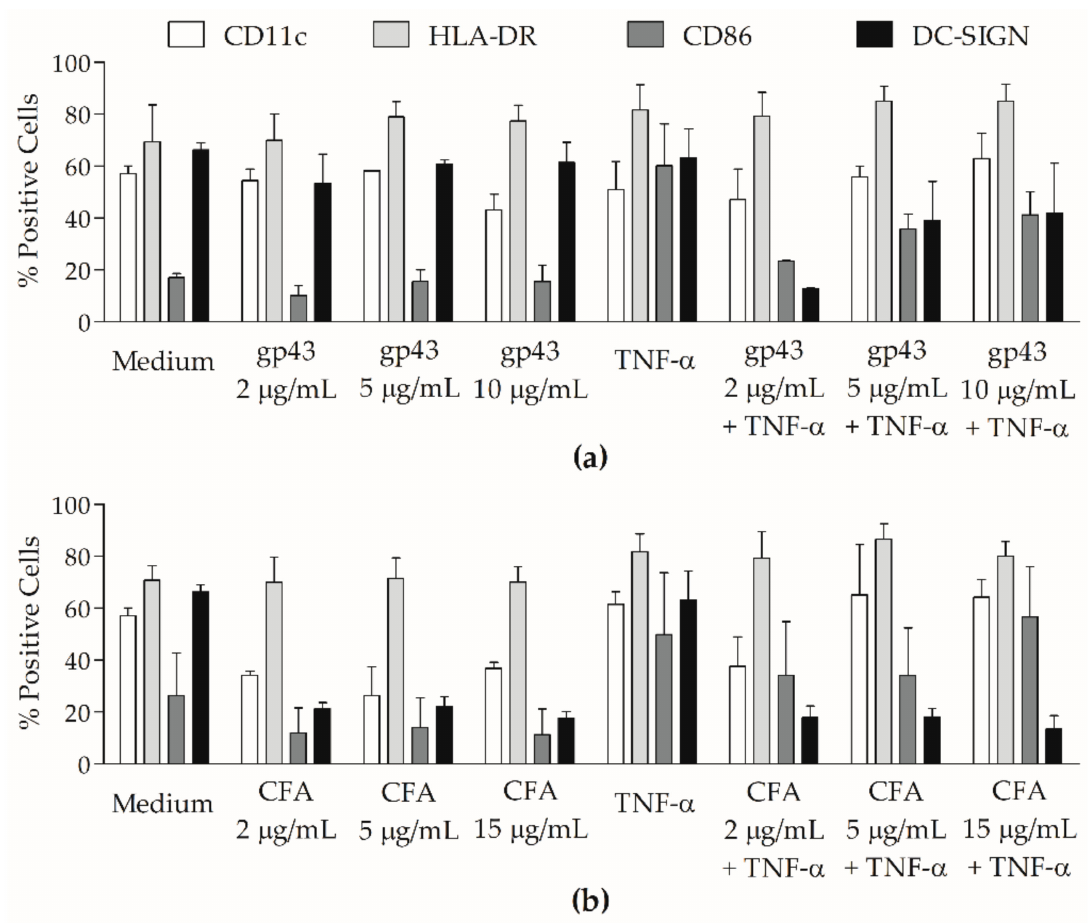
Figure 1. Influence of different concentrations of gp43 and cell-free antigen (CFA) of P. brasiliensis on expression of surface molecules by monocyte-derived dendritic cells (moDCs): Percentages of CD11c + (white bars), HLA-DR + (light grey bars), CD86 + (dark grey bars) and DC-SIGN + (black bars) cells were analyzed by flow cytometry on moDCs from patients with treated PCM ( n = 3), after 48 h of stimulation with ( a ) gp43 2, 5 or 10 µ g/mL; and ( b ) CFA 2, 5 or 15 µ g/mL, with or without TNF- α , or without any treatment (Medium). Results expressed as means with standard errors of the mean (SEM) of percentages of positive cells. There were no statistically significant